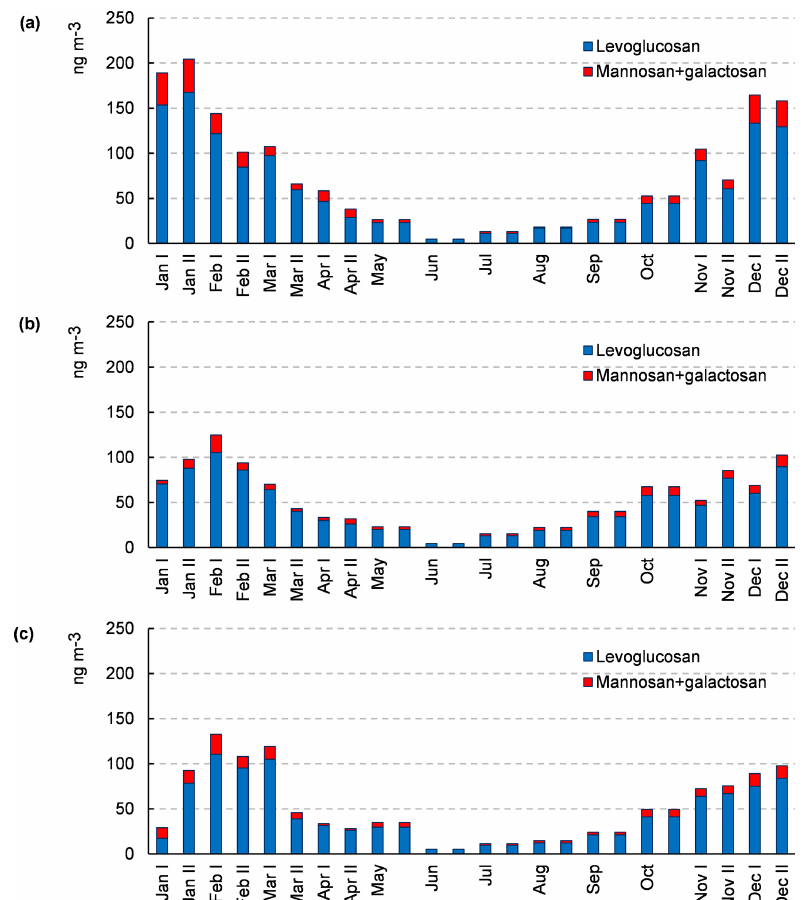
Figure 4. Distribution of annual measurement data for levoglucosan, mannosan and galactosan from three sampling locations. Mannosan and galactosan are determined as sum due to co-elution in the chromatogram: (a) DE, (b) EN and (c)